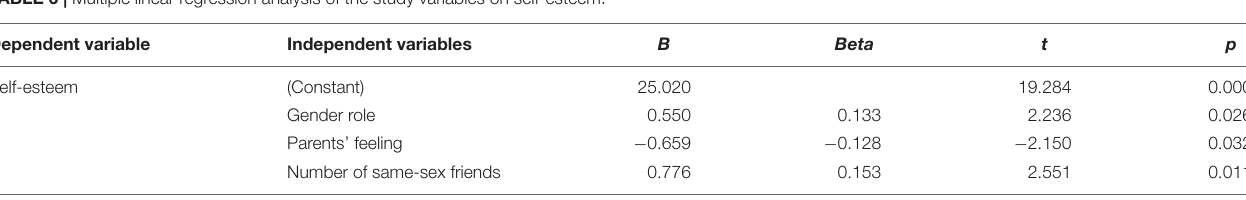
TABLE 6 | Multiple linear regression analysis of the study variables on self-esteem.